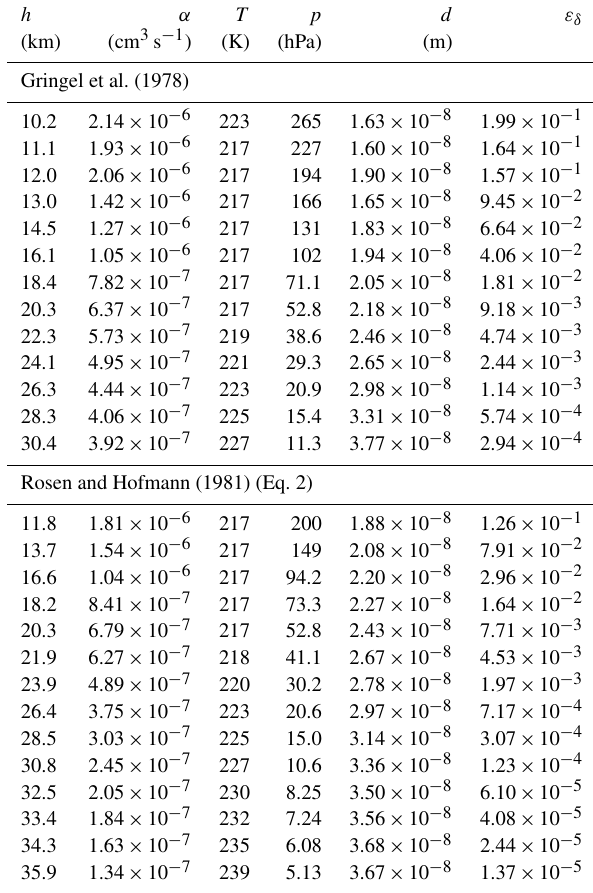
Table B1. Numerically calculated values for the ion–ion trapping distance, d , and analytically calculated values for the collision prob- ability in the limiting sphere, ε δ , for the reported field data of the ion–ion recombination coefficient, α , taken from Gringel et al. (1978), Rosen and Hofmann (1981), and Morita (1983). The data for T and p are taken from the US Standard Atmosphere (National Oceanic and Atmospheric Administration et al., 1976). For details, see Sect.